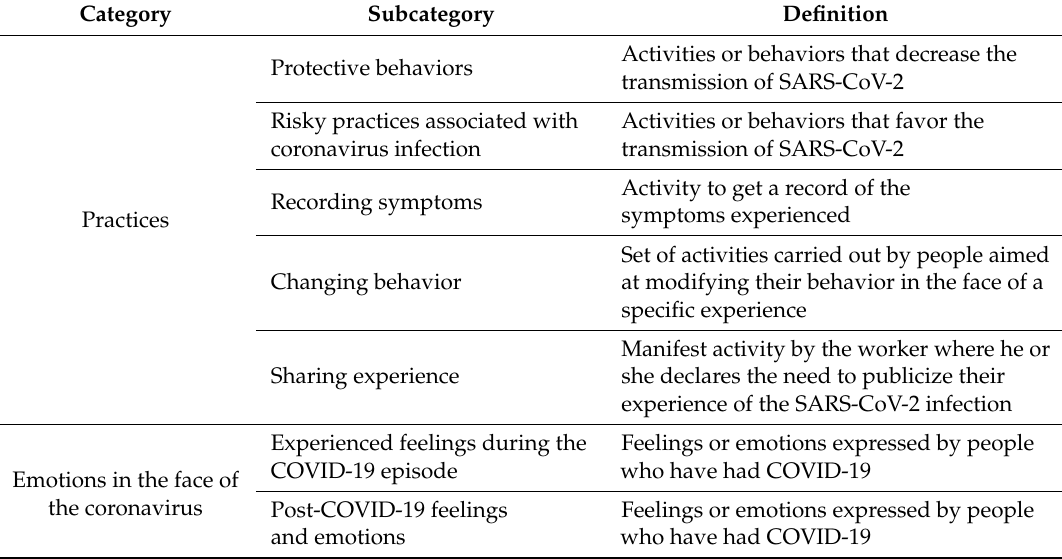
Table 5. Emergent categories and subcategories for qualitative